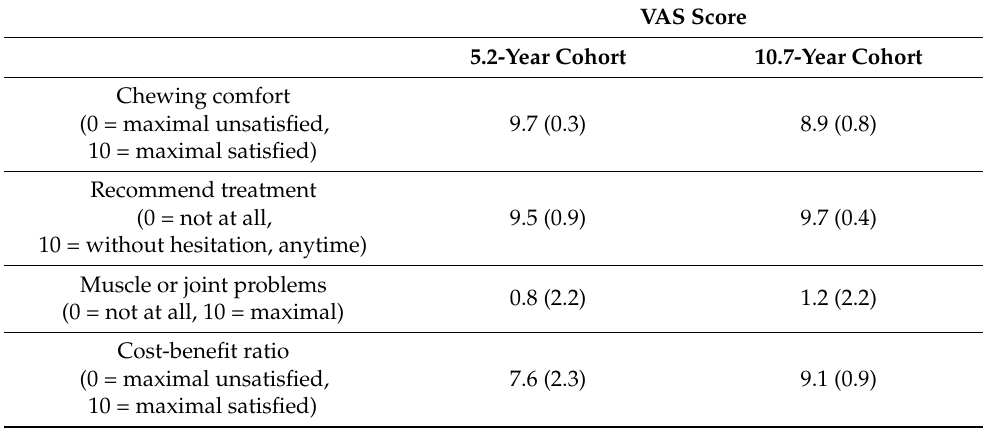
Table 6. Mean ( ± standard deviation) visual analogue scale (VAS) scores of the first (10.7-year) and second (5.2-year)